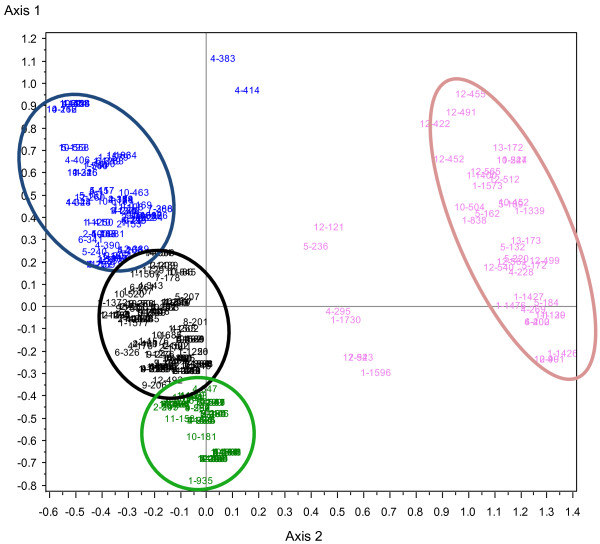
Identification of four distinct subgroups of dialysis patients with secondary hyperparathyroidism (SHPT) using multiple correspondence analyses. The horizontal axis defined the presence or absence of calcium supplementation, the presence or absence of treatment with cinacalcet, and serum PTH below or above 500 ng/L. The vertical axis defined a normophosphatemia, a hyperphosphatemia, the absence or presence of phosphorus binders, high or low level of alkaline phosphatases, the presence or absence of vitamin D supplementation, the presence or absence of calcium suplementation. Each patient is identified by a number and a color according to the following code: black for group 1 (“intermediate”), green for group 2 (younger with severe cardiovascular comorbidities), blue for group 3 (elderly patients with few cardiovascular comorbidities), pink for group 4 (“cinacalcet prescription”).